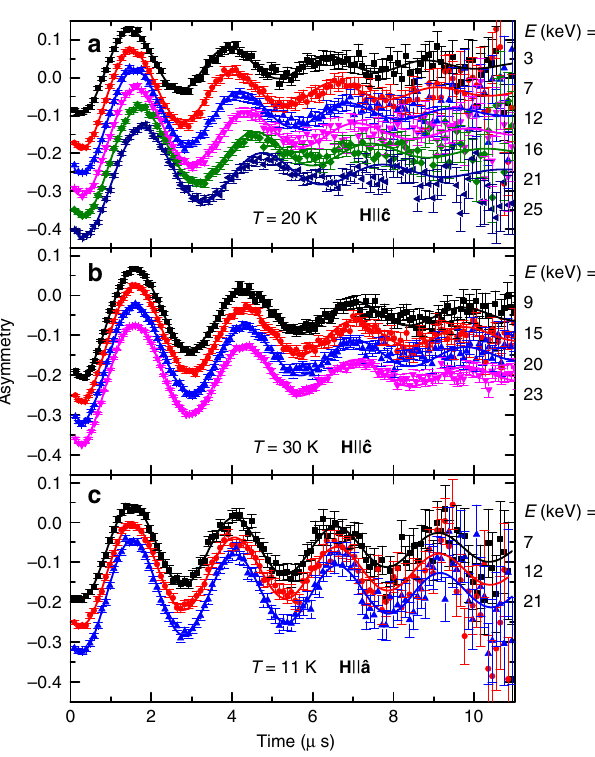
Fig. 5 LE- μ SR spectra. Asymmetry as a function of time for different muon implantation energies for: a H k b c , H = 26.7 Oe, T = 20 K, b H k b c , H = 26.7 Oe, T = 30 K, c H k b a , H = 26.3 Oe, T = 11 K. A clear frequency shift as a function of implantation energy is observed in a . In the ( b ) conditions, the Stiffnessometer clearly detects stiffness in the ab plane (Fig. 3a), while no frequency shift is observed by LE- μ SR within our sensitivity. For H k b a ( c ) there is no frequency shift at all temperatures. Each data point in panels ( a – c ) represents high statistics data accumulation and the error bar is the standard deviation